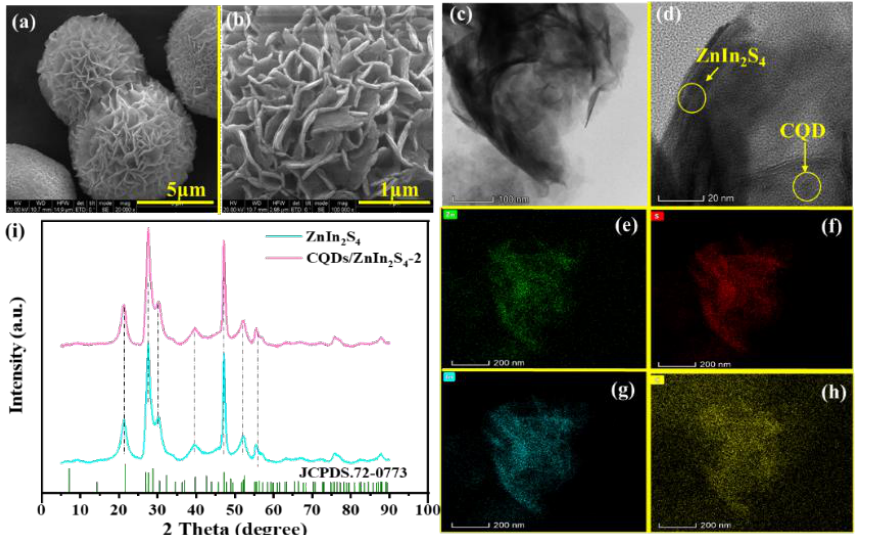
Figure 1. SEM images with different scales: 5 μm ( a ) and 1 μm ( b ); HRTEM images with different scales: 100 nm ( c ) and 20 nm ( d ); EDS elemental mapping images of C, Zn, In, and S elements ( e – h ); and XRD patterns of the as-prepared samples ( i ).